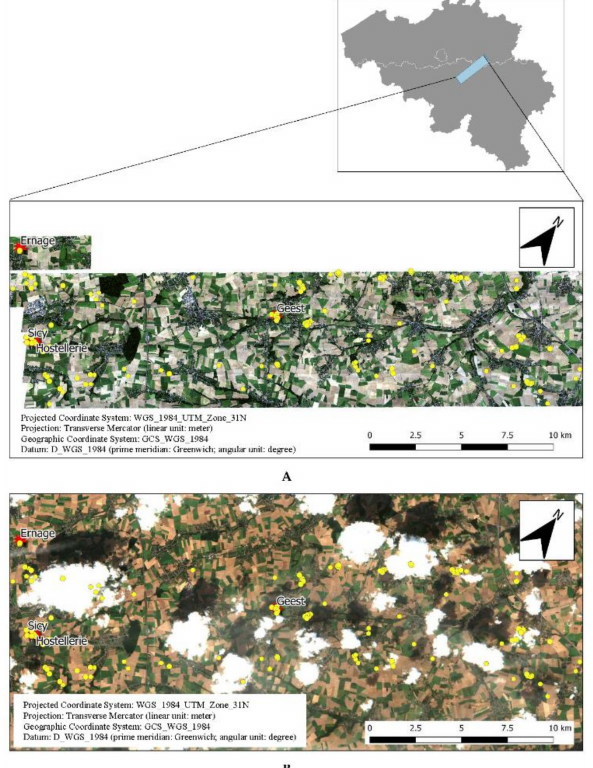
Figure 1. Location of the study area in the Belgian loam belt and RGB image acquired by ( A ) the hyperspectral Airborne Prism Experiment (APEX) sensor on 2 September 2018 (red: 616 nm, green: 551 nm, blue: 470 nm) and ( B ) the Multi-spectral Instrument (MSI) Sentinel-2 sensor on 24 August 2018 (red: 665 nm, green: 560 nm, blue: 490 nm). The yellow dots indicate the location of the sampling points, the red stars the location of the three extensively sampled